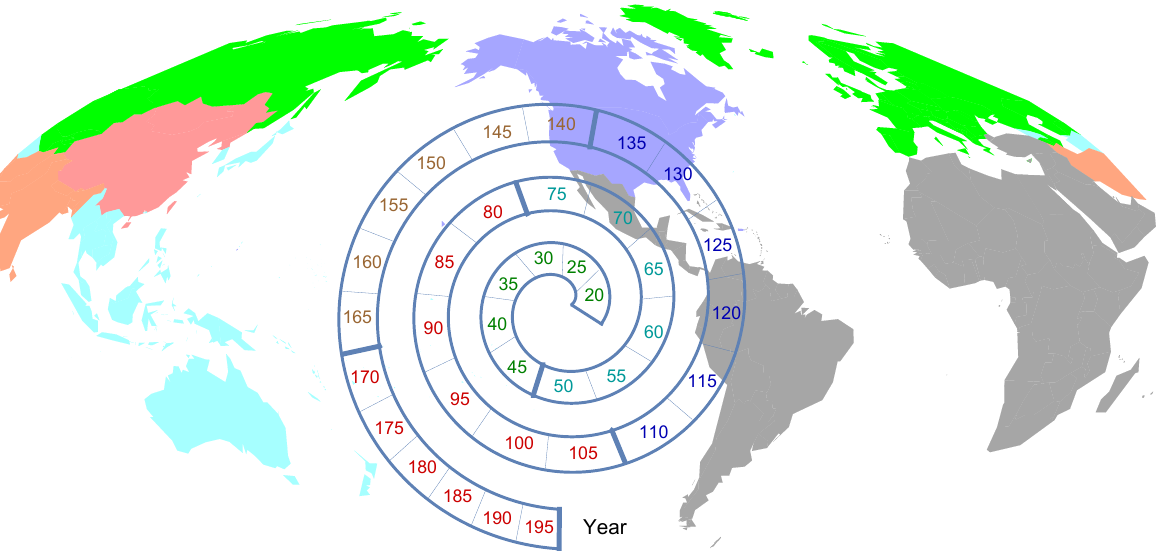
Figure 3. Map of six regions used. The spiral indicates decision times in years after Julian year 2000, with bold lines at the end of the 30-year “generations” when participants are tasked with having positive pot